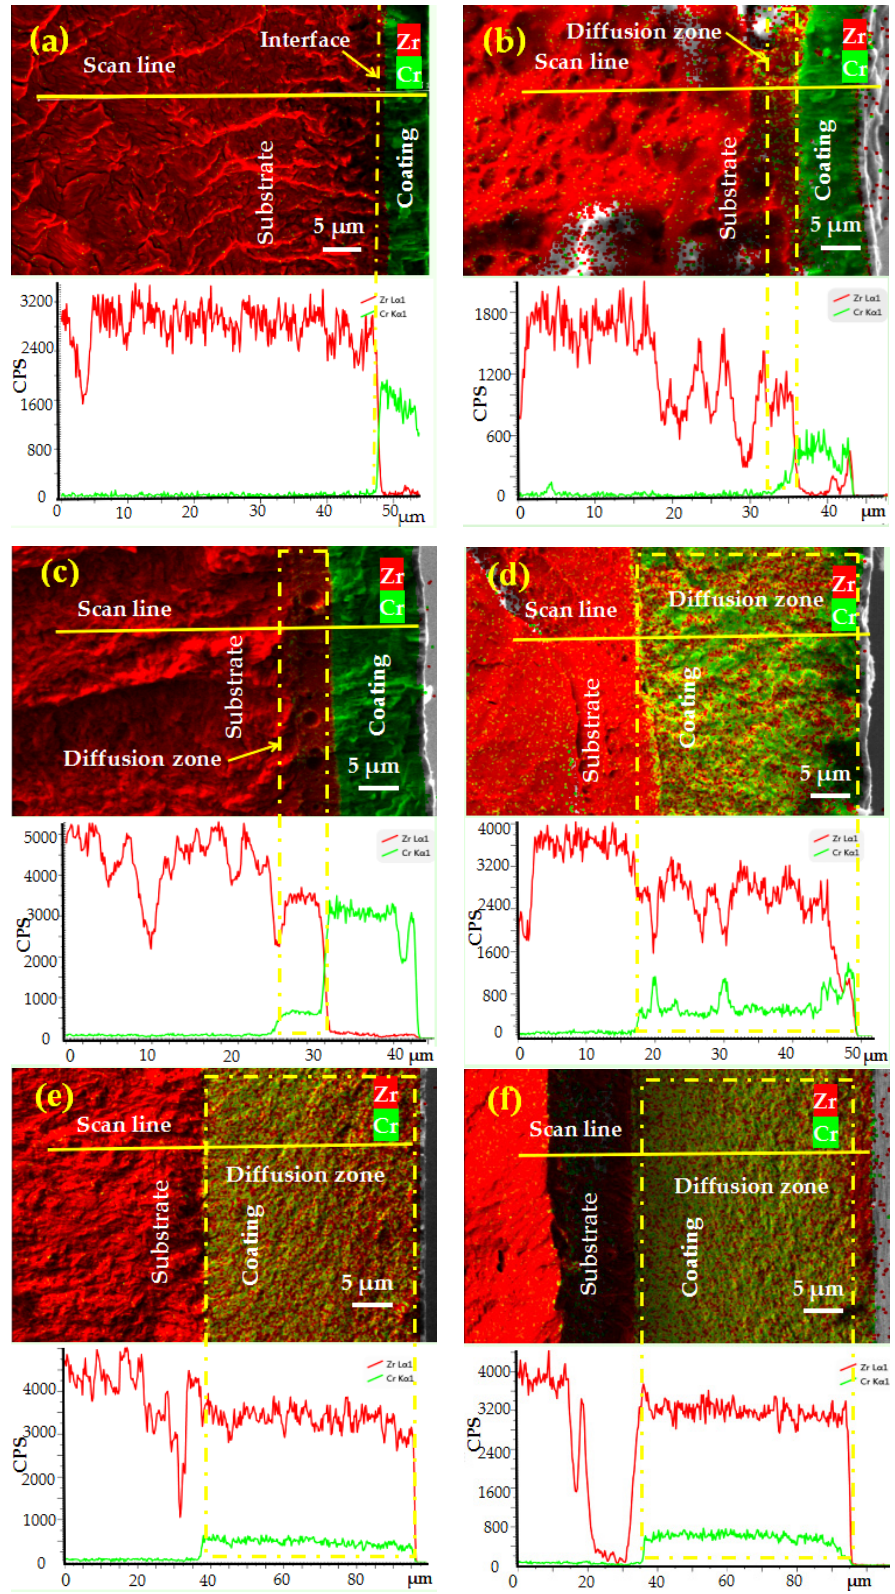
Figure 6. The SEM and corresponding energy disperse spectroscopy (EDS) of the tensile fracture of sample No. 1 ( a ), sample No. 2 ( b ), sample No. 3 ( c ), sample No. 4 ( d ), sample No. 5 ( e ), sample No. 6 ( f ).